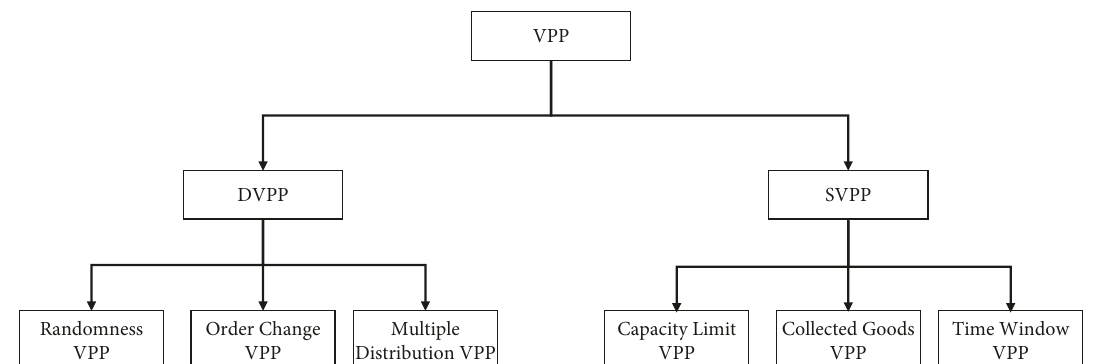
Figure 2: Category of vehicle path problem.